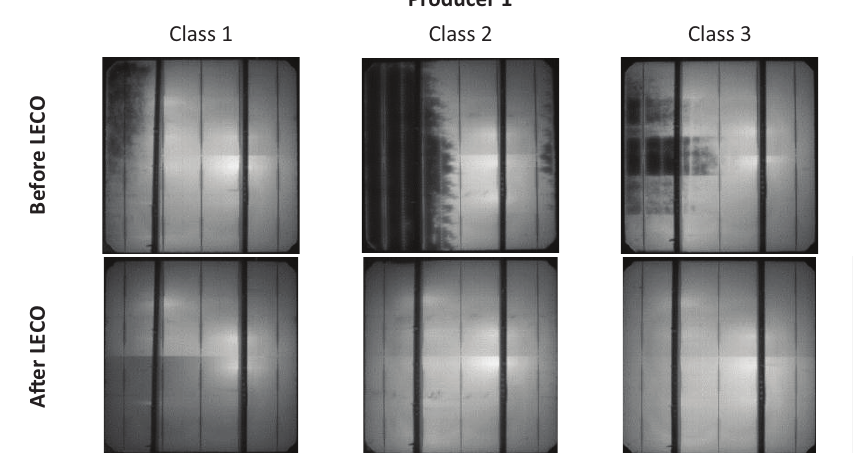
Fig. 12. Electroluminescence image of one representative solar cell of Class 1, Class 2 and Class 3 from Producer 1 before and after LECO treatment (from